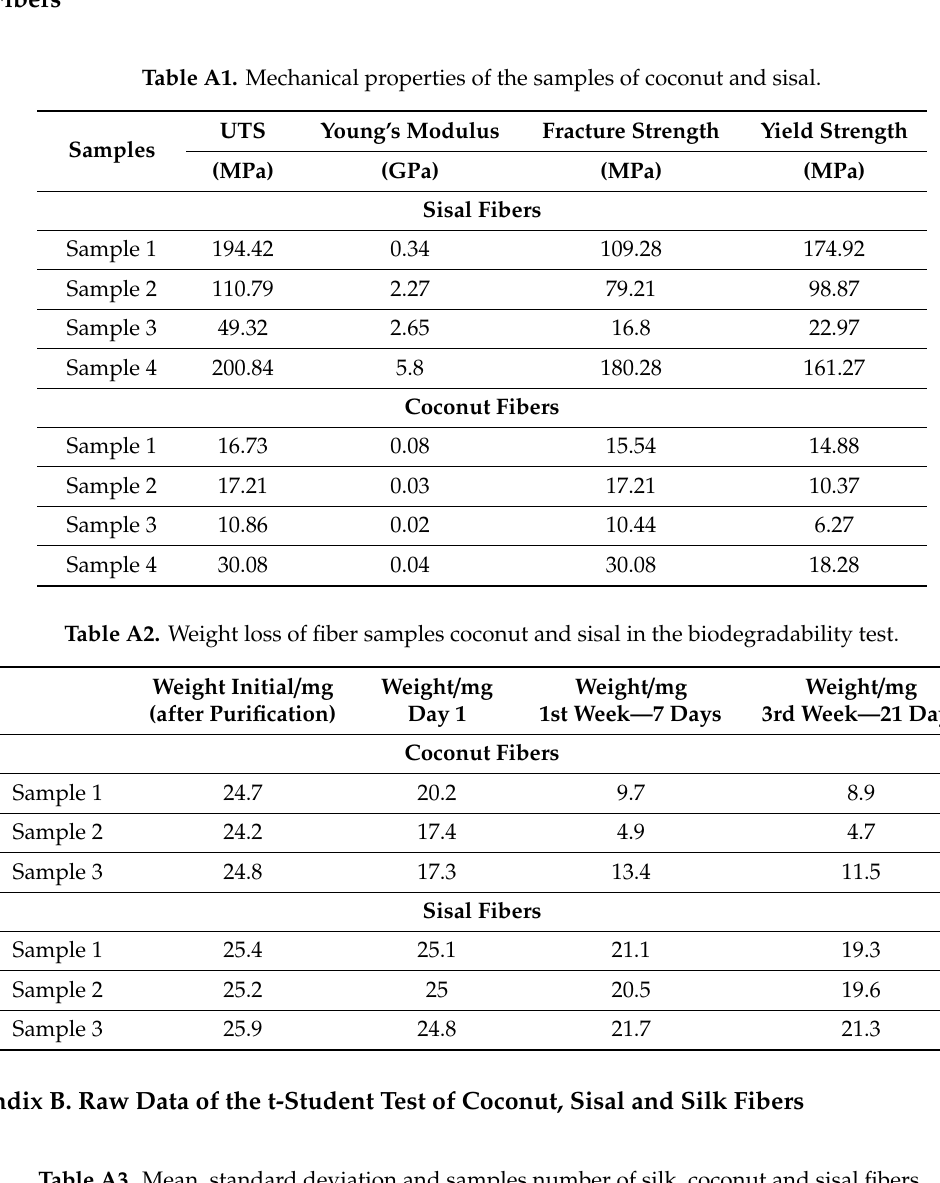
Table A3. Mean, standard deviation and samples number of silk, coconut and sisal